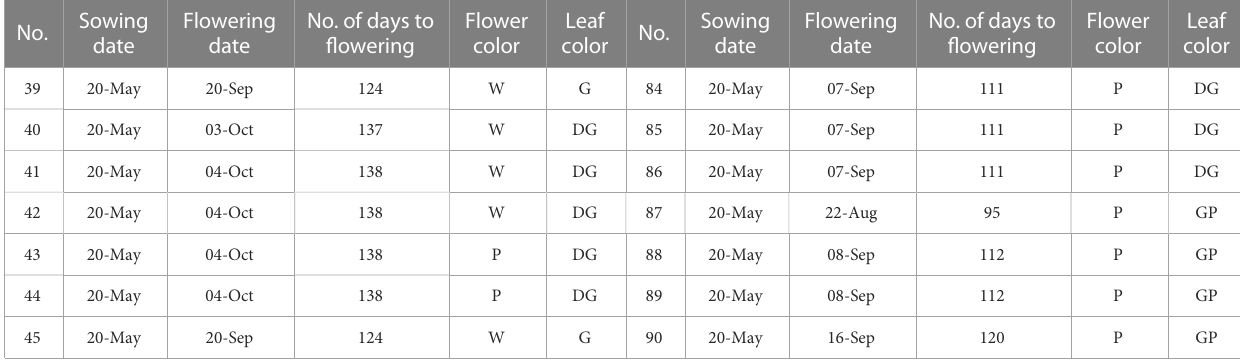
in the fi rst and second exons of PfHd3a in transgenic lines, PCR ampli fi cation was performed, and the adjacent sequence of PfHd3a was sequenced in T0 generation plants. Five plants had mutations only in G1 of the fi rst exon region. We measured the frequency of all mutant genotypes at the G1 target sites. We found that the main mutation types were single-base and amino acid frameshift mutations (Figure 6B). In the T2 generation, plants without exogenous DNA were selected. The fl owering phenotype was observed under SD conditions (10 L/14 D). The gene-edited perillas showed signi fi cantly late fl owering, resulting in approximately 50% leaf production enhancement compared to the control (Figures 6C – E), reiterating that PfHd3a is the main fl owering activator in